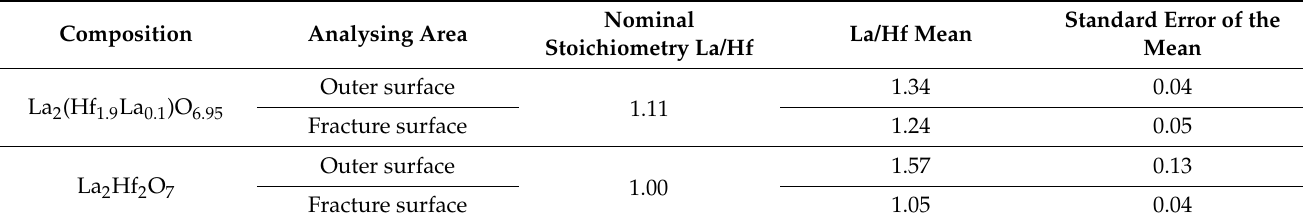
Table 2. Average La/Hf ratio on the outer and fracture surfaces of ceramics: SEM/EDX ten